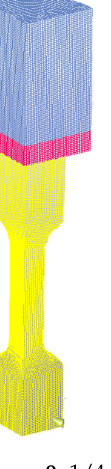
Figure 9. 1/4 LS-DYNA calculation model.